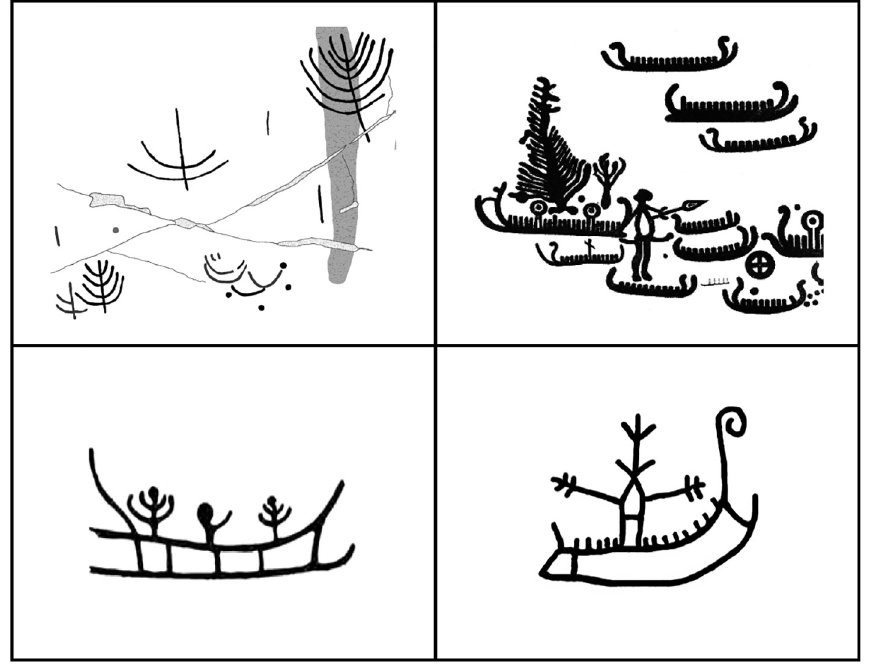
Figure 5. A variety of tree motifs on rock art in South Scandinavia. Top left (a): individual tree motifs from Borg, Östergöt- land (modified from Broström and Ihrestam 2013). Top right (b): two trees (one a possible spruce) from the Lökeberg panel, Bohuslän (modified from Holmberg, 1848, p.134). Bottom left (c): Trees growing out of a boat? From Himmelstalund, Östergöt- land (modified from Nordén, 1926, p. 261). Bottom right (d): A hybrid tree-anthropomorph on a boat (modified from original documentation by E. Kjellén, Museum of